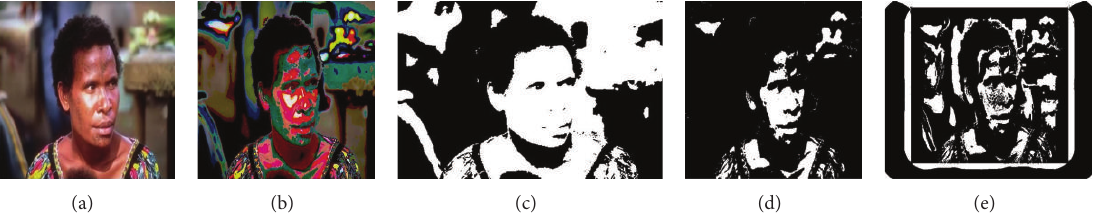
Figure 5: (a) Original image, (b) image of bit plane 7, (c) binarization of original image using mean threshold, (d) binarization of bit plane 7 with mean threshold, and (e) binarization of bit plane 7 with Niblack’s method of local threshold.